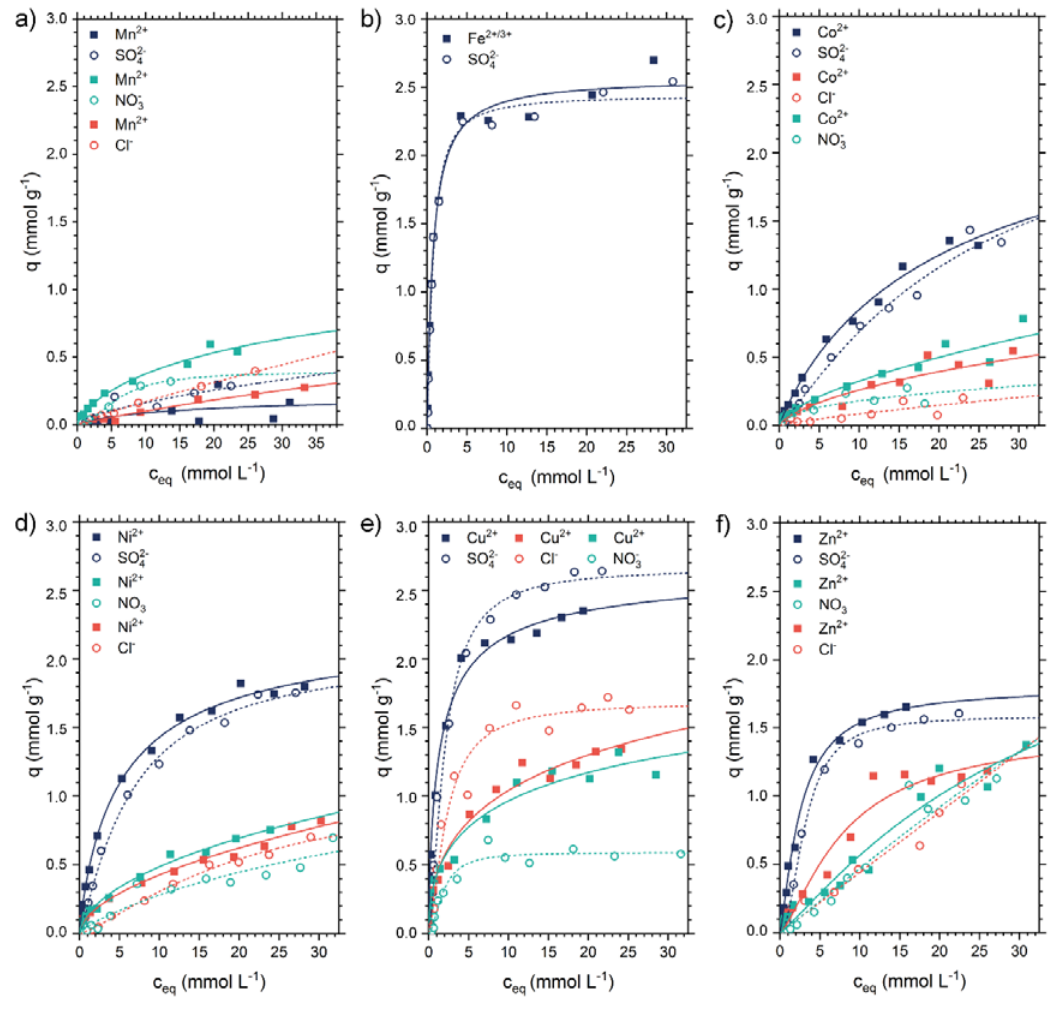
Figure 1. Adsorption isotherms of heavy metal ions (full symbols) and the corresponding anions (open symbols). Batch adsorption experiments with the heavy metal salts: ( a ) MnSO 4 (blue), MnCl 2 (red), and Mn(NO 3 ) 2 (green), ( b ) FeSO 4 (blue), ( c ) CoSO 4 (blue), CoCl 2 (red), and Co(NO 3 ) 2 (green), ( d ) NiSO 4 (blue), NiCl 2 (red), and Ni(NO 3 ) 2 (green), ( e ) CuSO 4 (blue), CuCl 2 (red), and Cu(NO 3 ) 2 (green), and ( f ) ZnSO 4 (blue), ZnCl 2 (red), and Zn(NO 3 ) 2 (green) onto chitosan at 298 K dependent on the equilibrium concentration after adsorption process. Langmuir isotherms were fitted for metal ions (solid lines) and Langmuir isotherms for anions (dashed lines). The pH of the solutions was not adjusted (see Figure S1).